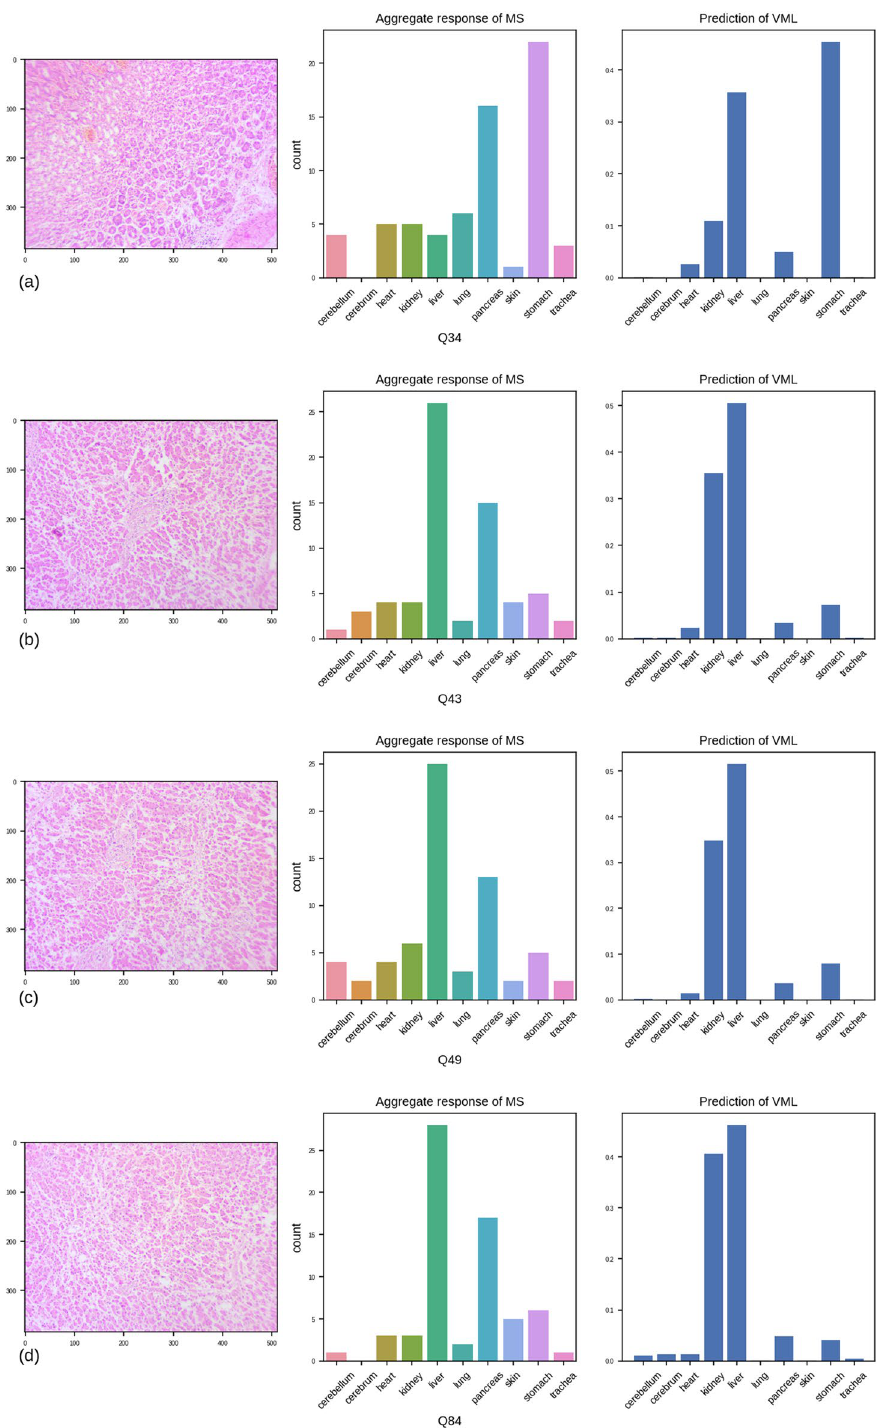
Figure 13. The four images in the quiz set where both medical students and VML model have produced mixed responses, with the 2nd commonest response having more than half the probability/ frequency of the commonest response. ( a ) stomach, ( b ), ( c ) & ( d ) liver. (Figure generated by Matplotlib python library, version 3.3.4, https:// matpl otlib.